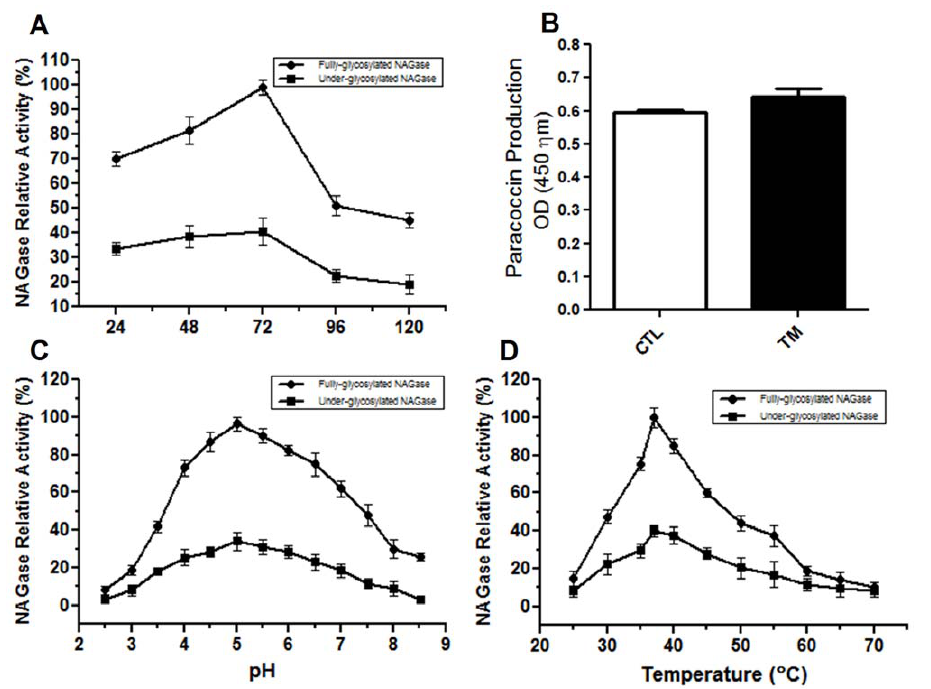
Figure 5. Effect of tunicamycin (TM) on the NAGase (N-acetyl- b - D -glucosaminidase) activity of P.brasiliensis yeasts. P. brasiliensis yeasts cultured in YPD medium in the absence or presence of 15 m g/mL TM were disrupted to obtain crude extracts. The time-course profile of NAGase activity, as detected by the degradation of p NP-GlcNAc substrate (A); the effect of TM on the expression of paracoccin, a P. brasiliensis protein with NAGase activity, shown by ELISA using anti-paracoccin IgY and measured at 450 nm (B); and profiles of optimal pH (C) and temperature (D) for the fully glycosylated and underglycosylated NAGases. Maximum activity was standardized as 100% and NAGase activities were measured at 405 nm. Data are representative of 3 independent assays.